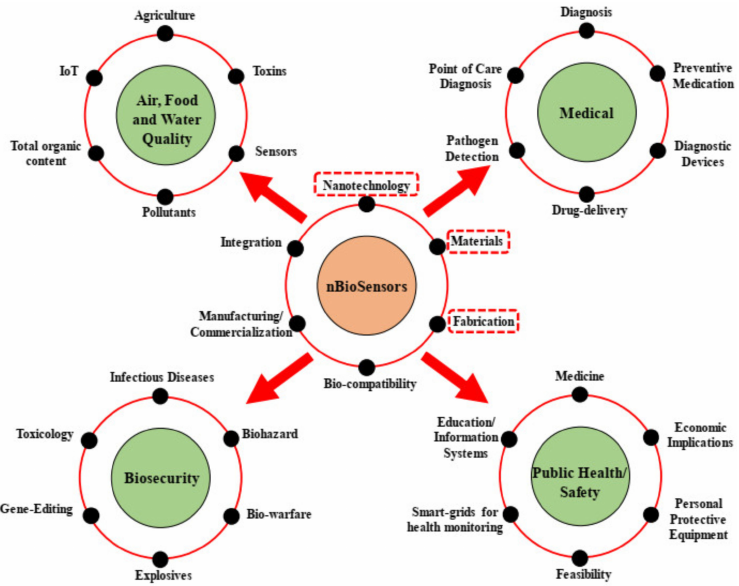
Figure 2. Advancements and applications of nano-biosensors (reprinted from Ref. no. [2], copyright 2021,